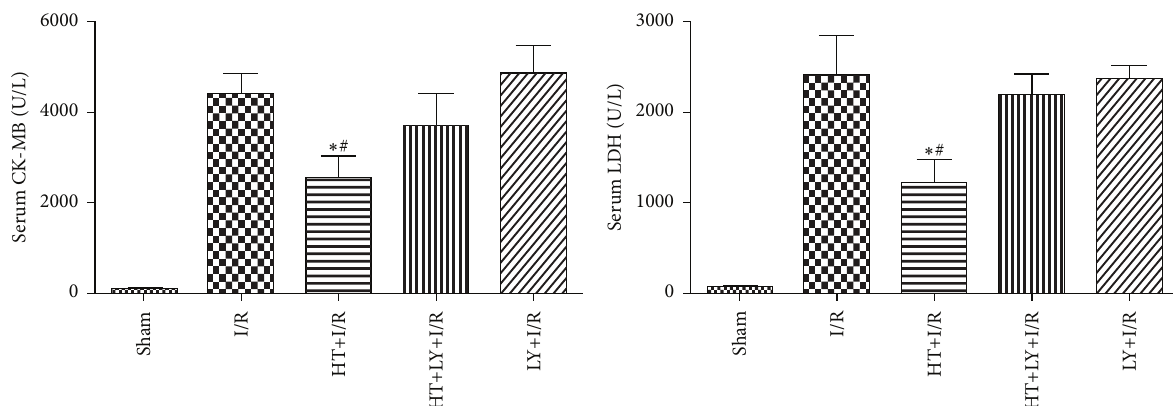
Figure 2: Effects of HT on serum levels of CK-MB and LDH ( 𝑛 = 20 for each group). ∗ 𝑃 < 0.05 versus I/R group. # 𝑃 < 0.05 versus HT+LY+I/R group.